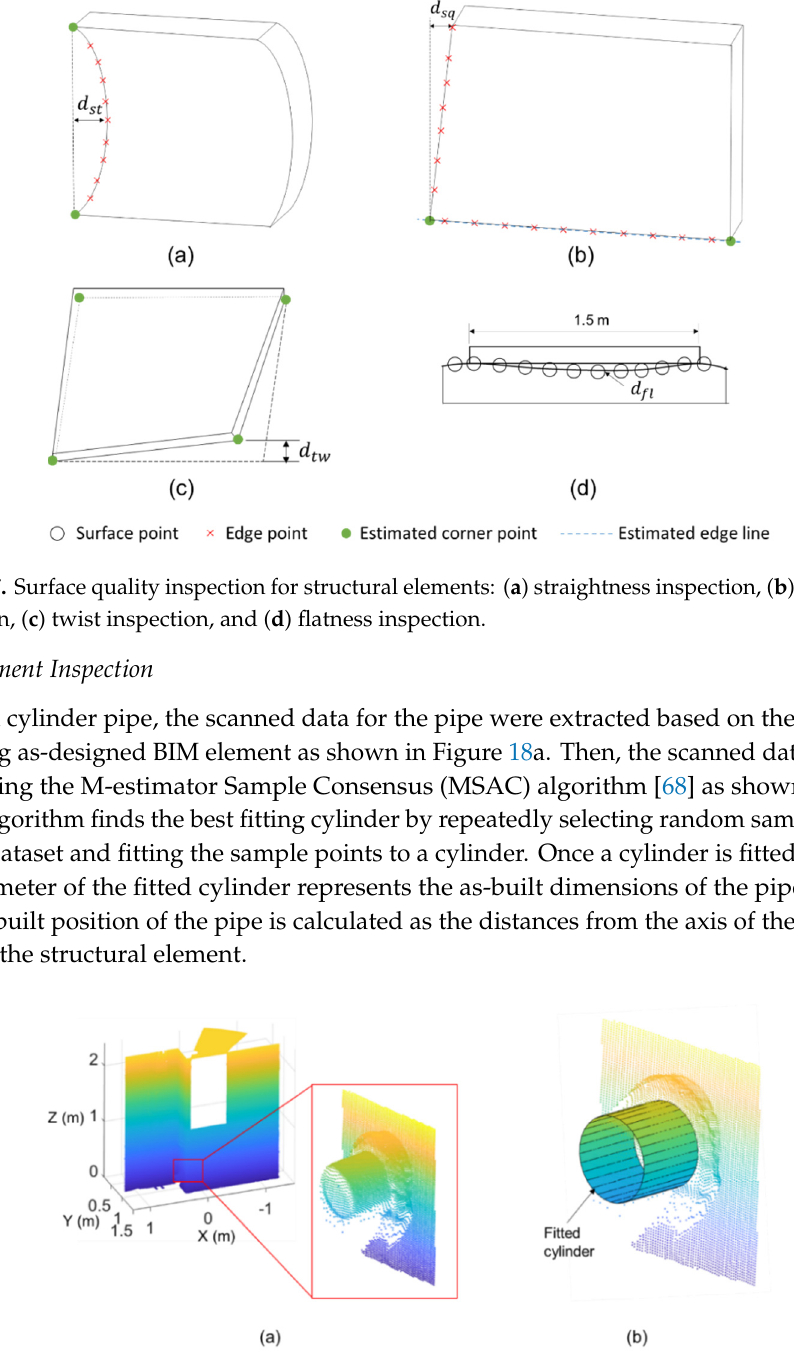
Figure 18. Extraction of pipes: ( a ) scanned data near the element and ( b ) cylinder fitting.